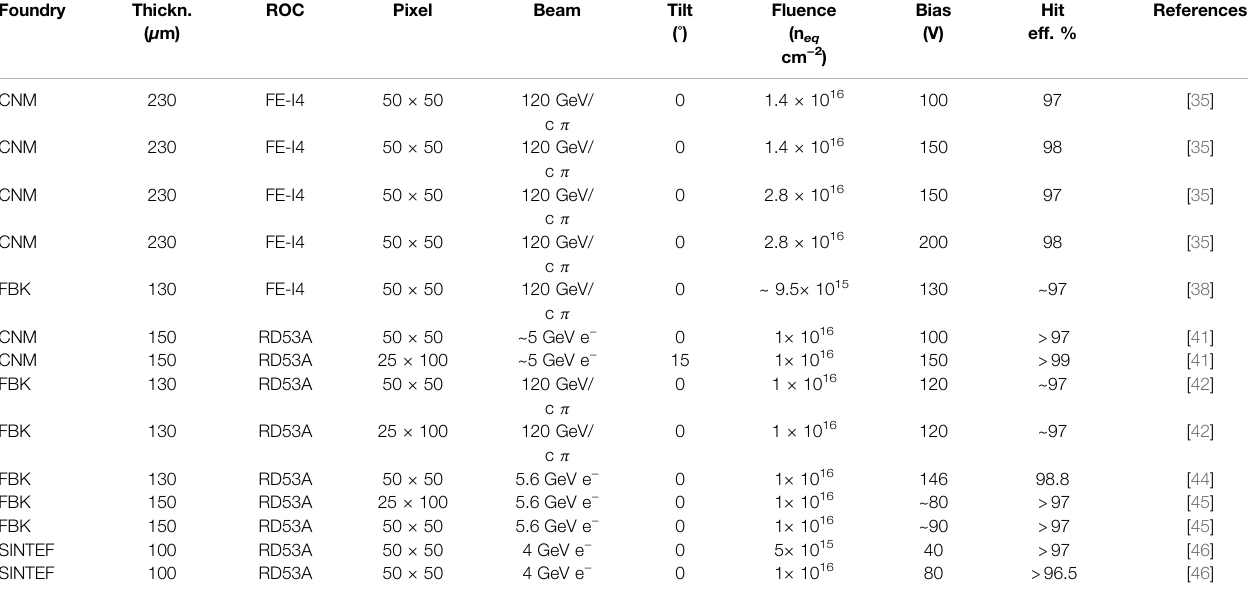
TABLE 1 | Summary of the main results from beam tests of small-pitch 3D pixel sensors from different foundries after irradiation. Foundry Thickn. ( μ